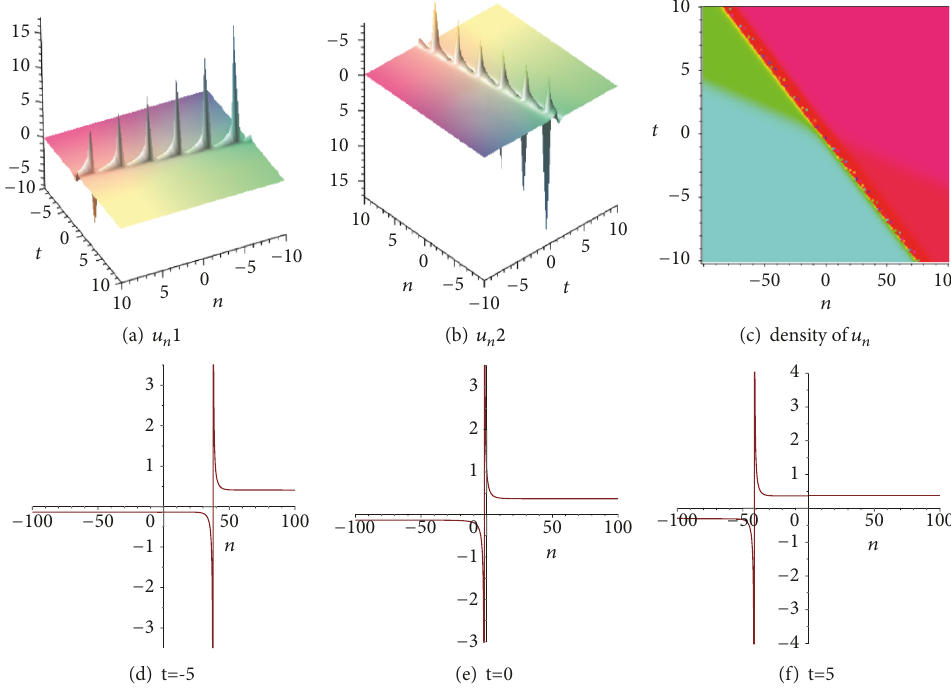
Figure 1: A structure of soliton solution for 𝑢 𝑛 in (66) with 𝜆 1 = 0.5,𝜆 2 = 2, 𝛾 1 = 1, 𝛾 2 = −1 . Figures (a) and (b) are three-dimensional graphs of 𝑢 𝑛 . Figure (c) is the density plot of 𝑢 𝑛 and Figures (d), (e), and (f) are structures of the solution 𝑢 𝑛 at different time.